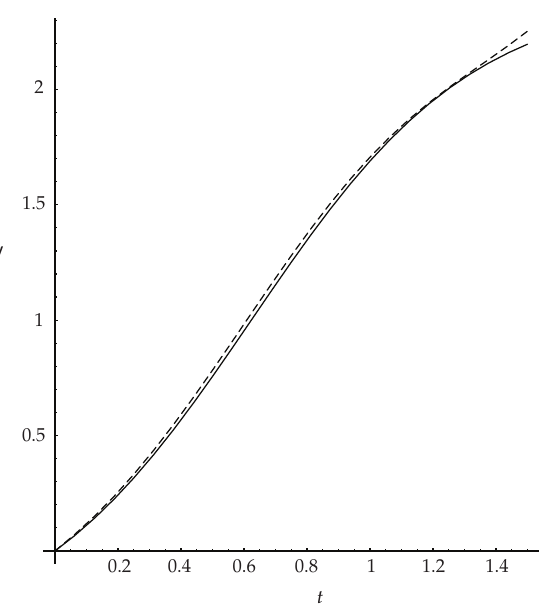
Figure 4: Dashed line: Approximate